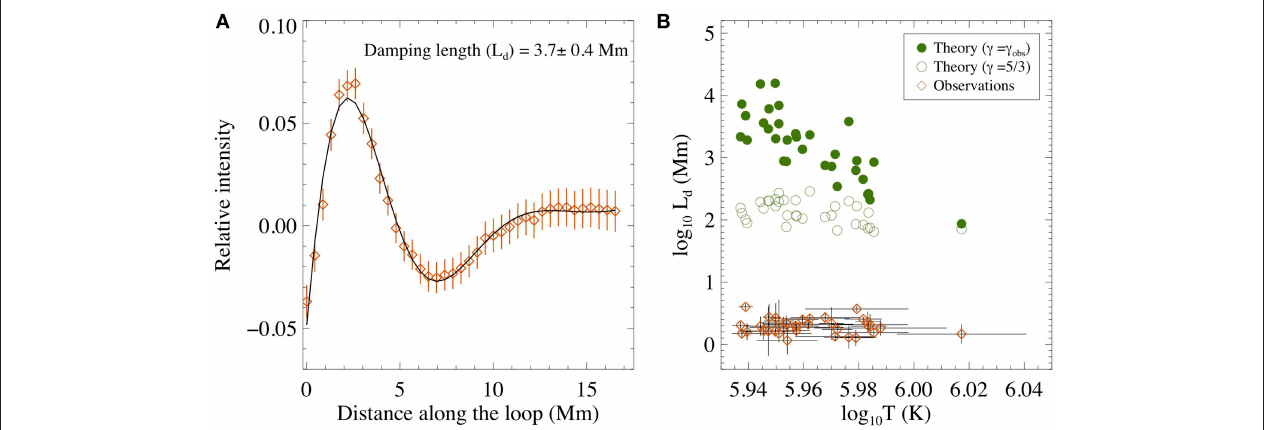
FIGURE 2 | (A) Spatial variation of the relative intensity at the temporal location marked by the white dashed line in Figure 1c . The vertical bars denote the respective uncertainties. The solid curve represents the best fit to the data for an exponentially decaying sine wave model following Equation (1). The obtained damping length value from the fitted curve is listed in the upper-right corner of the plot. (B) Damping lengths extracted from all of the selected loop structures, plotted as a function of the localized temperature on a log-log scale. The orange diamonds represent the values obtained following the phase tracking method shown in (A) , whereas the green circles represent the theoretical values estimated from damping due to thermal conduction. The open and filled circles, respectively, highlight the values computed from a constant γ ( 5 / 3) and those computed using γ values extracted from observations (Krishna Prasad et al., 2018). The vertical and horizontal bars = on the observed values denote the corresponding propagated uncertainties.